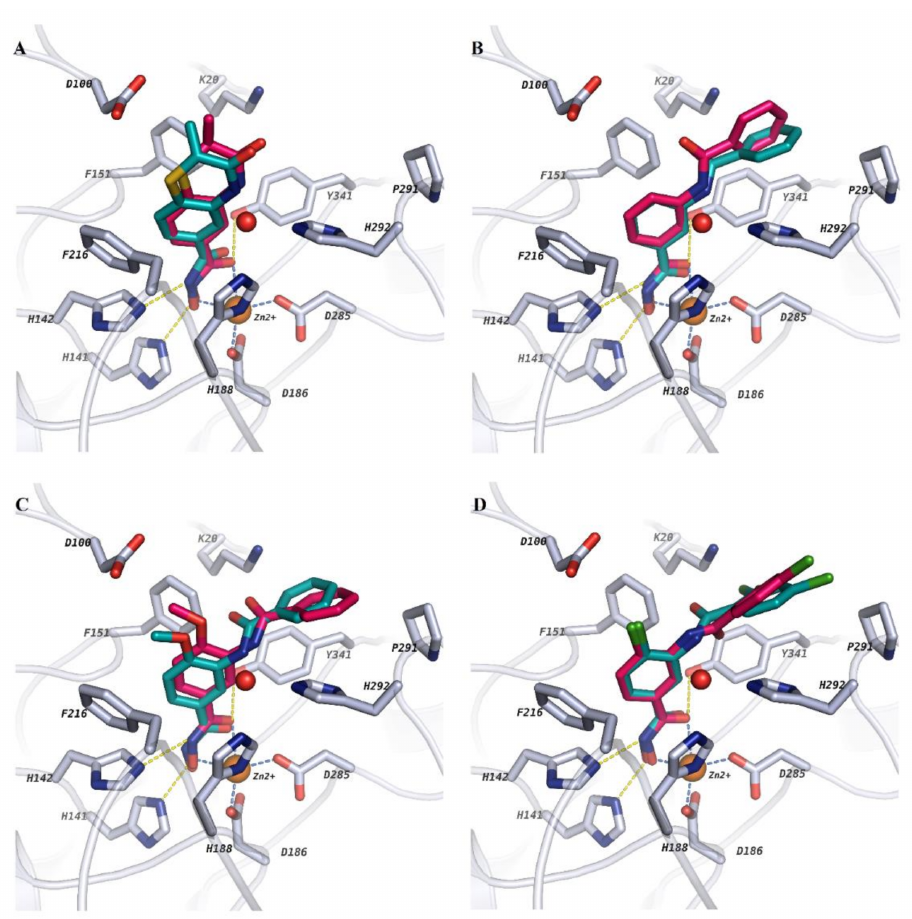
Figure 4. Comparing the docking poses derived from our docking protocol with the crystallized sm HDAC8 ligands. Co-crystallized ligands were taken from the corresponding PDB IDs by overlap- ping ( A ) PDB ID: 4BZ8, ( B ) PDB ID: 5FUE, ( C ) PDB ID: 6HT8 and ( D ) PDB ID: 6HU1. Co-crystallized ligands with their experimentally determined binding mode are shown in cyan while the docking pose of the ligands from our docking protocol in PDB ID: 6HRQ are shown in magenta. In the different pictures, protein backbones are shown as ribbons and side chains of key amino acid residues in the active sites are shown as white sticks. Catalytic zinc ion and conserved water molecule are shown as orange and red spheres,